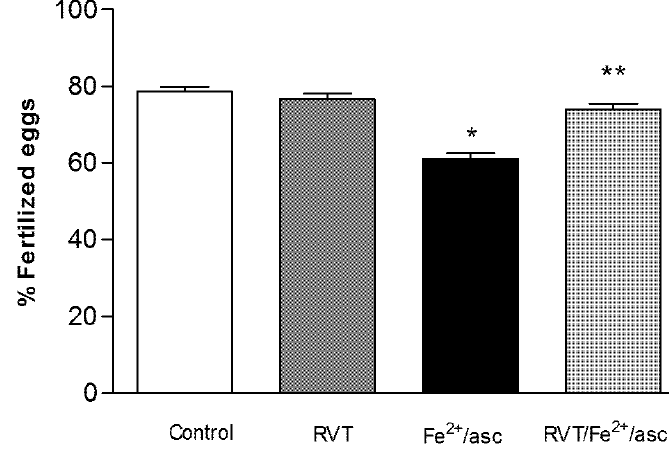
Figure 6. Effect of RVT on IVF capability. Spermatozoa from the different groups were incubated with eggs during 24 h at 37 °C in an incubator under an atmosphere /95% air. Eggs with 2 to 6 cells were considered fertilized. Values represent the of 5% CO 2 mean ± SD of three independent experiments performed in duplicate. * p < 0.001 vs. control group. ** p < 0.001 vs. Fe 2+ /asc